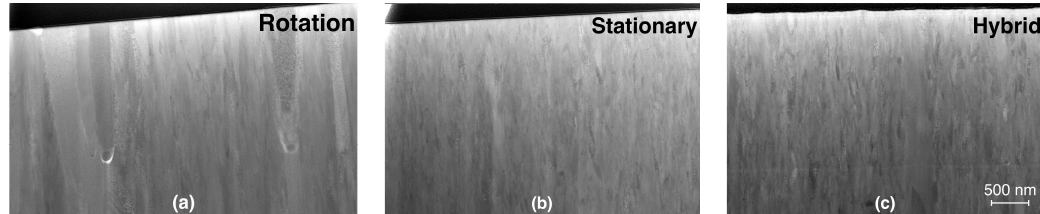
Figure 1. STEM micrographs of TiAlN cross-sections, synthesized with ( a ) substrate rotation, ( b ) stationary, and ( c ) hybrid deposition geometry. All coatings were grown at floating potential and the scale bar in ( c ) is valid for all micrographs.